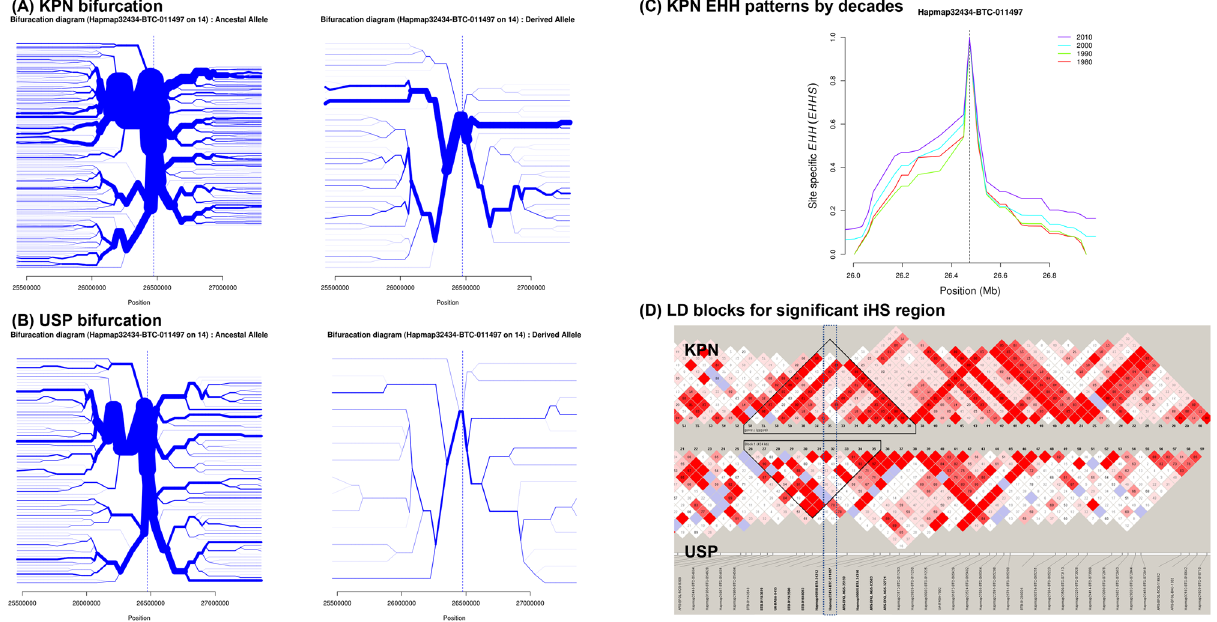
Figure 4. The bifurcation, EHH and Haploview results for significant derived allele in Hanwoo: ( A ) is bifurcation result of ancestral and derived allele for KPN population and ( B ) USP population. Both populations have one strong derived haplotype in this significant associated region. ( C ) EHH result for KPN population has similar pattern with ancestral allele, but 1980s and 1990s have not much differences and their ( D ) LD structure by Haploview analysis was confirmed extended block to right hand side in selected (KPN) population on BTA14 Hapmap32434-BTC-011497 SNP position. EHH expended haplotype homozygosity, KPN 30-year selected Korean proven bull, USP unselected